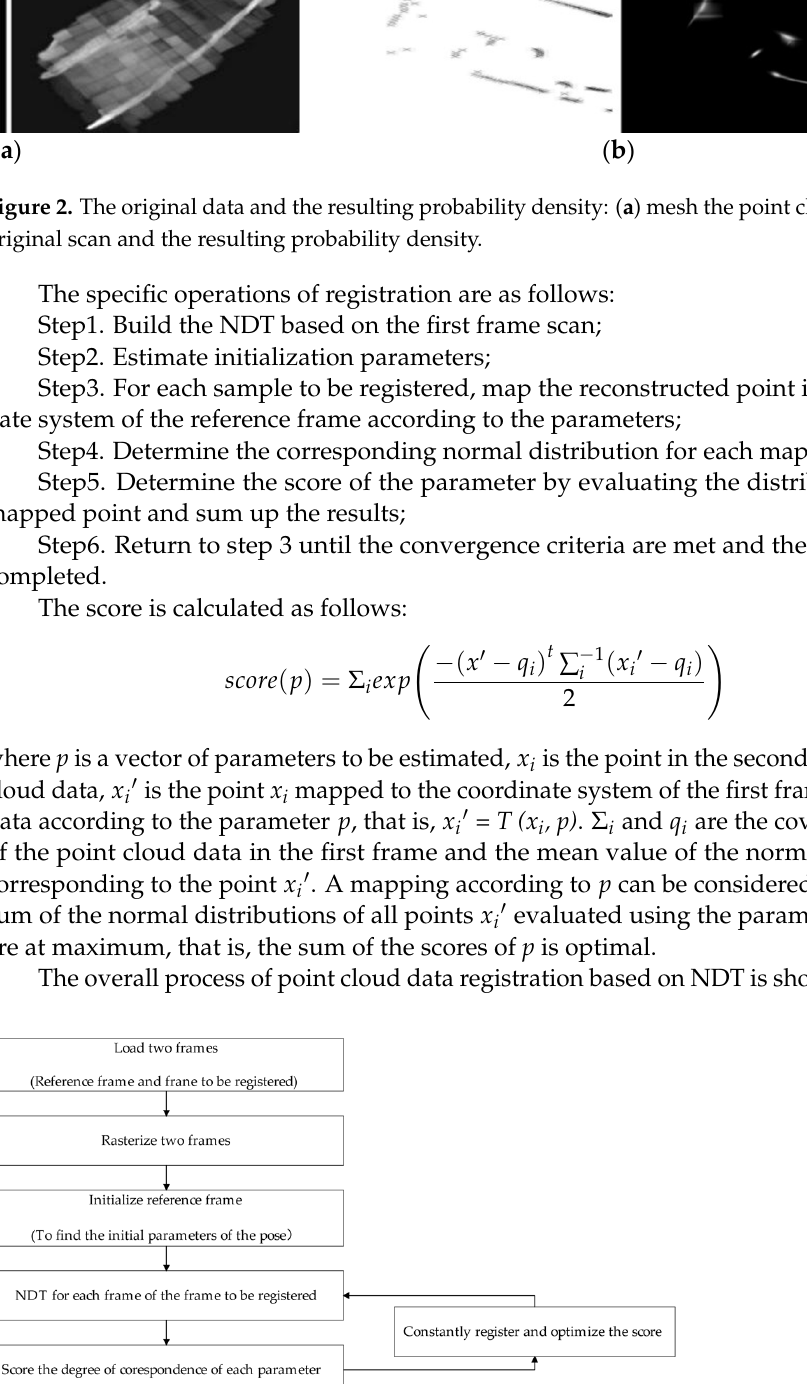
Figure 4. The process of point cloud mapping. In Figure 4, the coordinate system transformation adopts the TF coordinate system transformation. If the coordinates of a point in the radar coordinate system are 𝑃 (cid:3013) (cid:4666)𝑋 (cid:3013) , 𝑌 (cid:3013) (cid:4667) , then the coordinates of a certain point in the map after conversion are 𝑃 (cid:3014) (cid:4666)𝑥 (cid:3040) , 𝑦 (cid:3040) (cid:4667) , and the map coordinate system is a fixed coordinate system. The coordinate system is the same as the world coordinate system, then: 𝑅 (cid:3400) 𝑃 (cid:3013) (cid:3397) 𝑡 (cid:3404) 𝑃 (cid:3014)